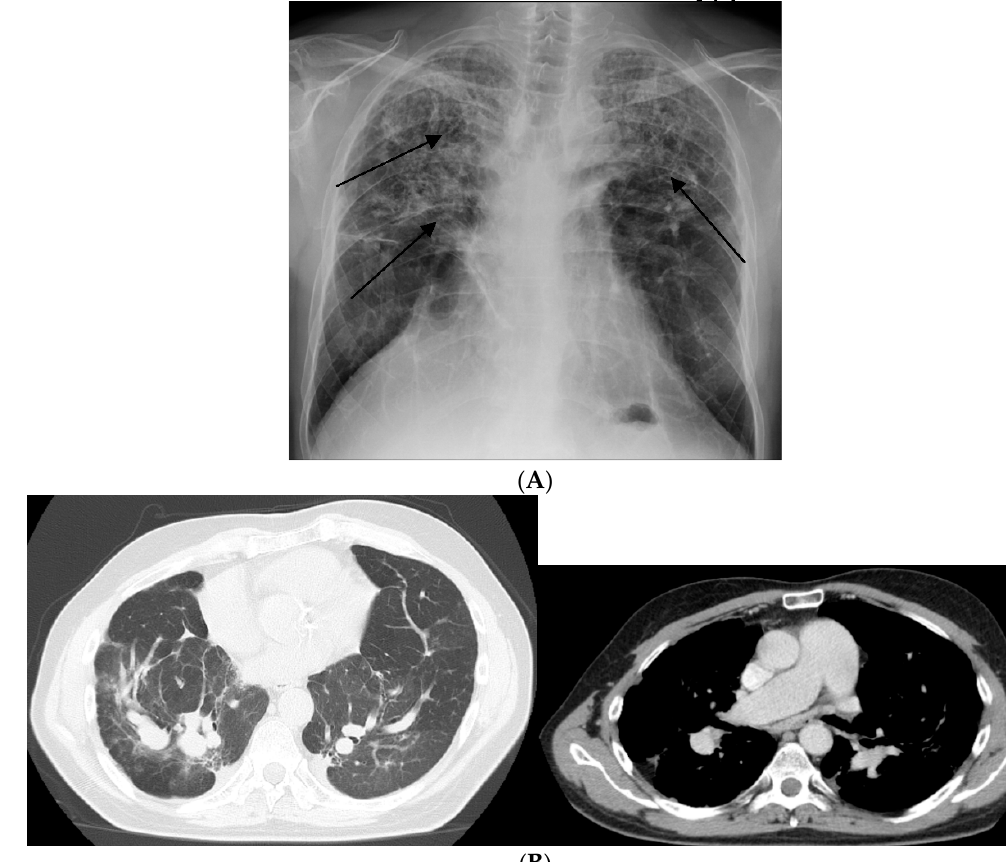
Figure 3. Chronic form of sarcoidosis complicated with pulmonary arterial hypertension (PAH). ( A ) Posterior-anterior chest radiograph of a 58-year-old man listed for lung transplant demonstrating extensive parenchymal scarring throughout both lungs, most marked in the upper lungs (arrows) and in the perihilar regions. ( B ) high-resolution CT showing intra-parenchymal enlargement of pulmonary arteries and enlarged pulmonary trunk at the bifurcation.